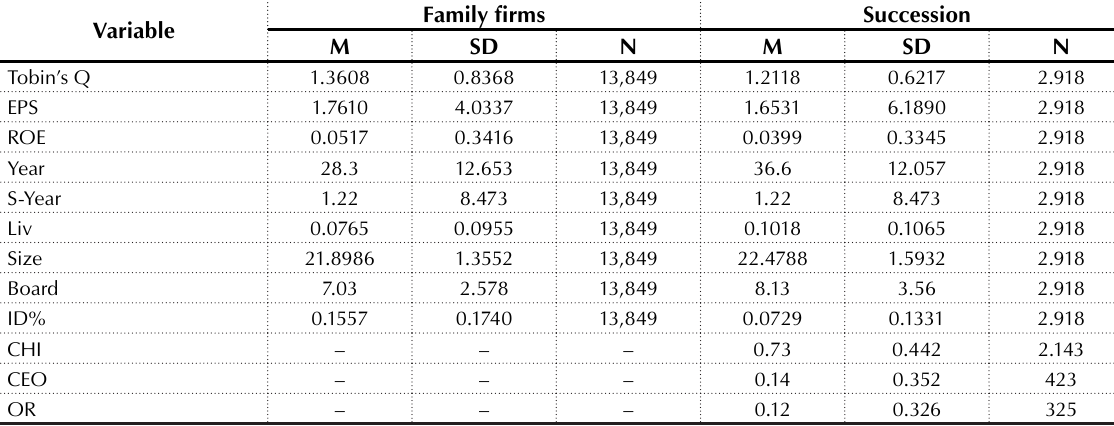
Table 1. Descriptive